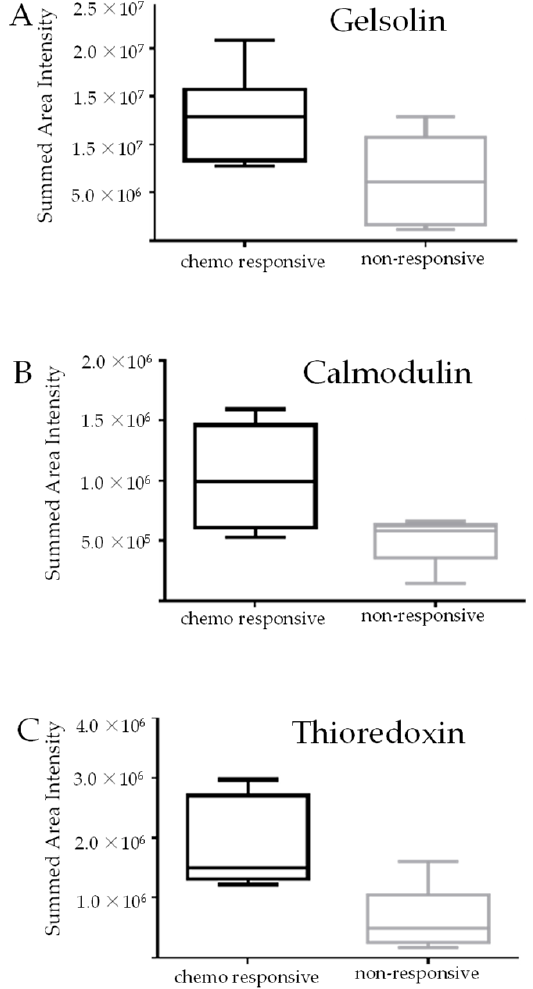
Figure 1. DIA analysis of HGSOC patients who responded to chemotherapy (n = 6) compared to those who did not (n = 6). Relative abundance of ( A ) gelsolin (fold change = 1.84, p value = 0.035), ( B ) calmodulin (fold change = 2, p value = 0.029), and ( C ) thioredoxin (fold change = 2.47, p value = 0.0086). Box and whisker plots were generated comparing the area intensities of each protein in the chemo- responsive and non-responsive patient cohorts. Significance was calculated using un-paired t -tests using the GraphPad Prism. The error bars indicate the standard deviation.